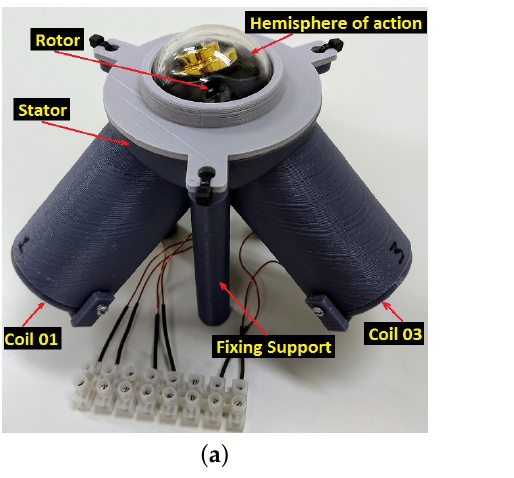
Figure 1. ( a ) The main body of the proposed spherical motor and some of its components. ( b ) A: Magnetic field ( H ) resulting from each stator coil ( ± H 1, ± H 2, ± H 3); B: Compact coil composed of N turns and representation of manufacturing variables ( h is the height of the coil ( h 1 = beginning, h 2 = end), ρ is the coil radius ( ρ 2 = outside, ρ 1 = inside), and i is the current in the wire